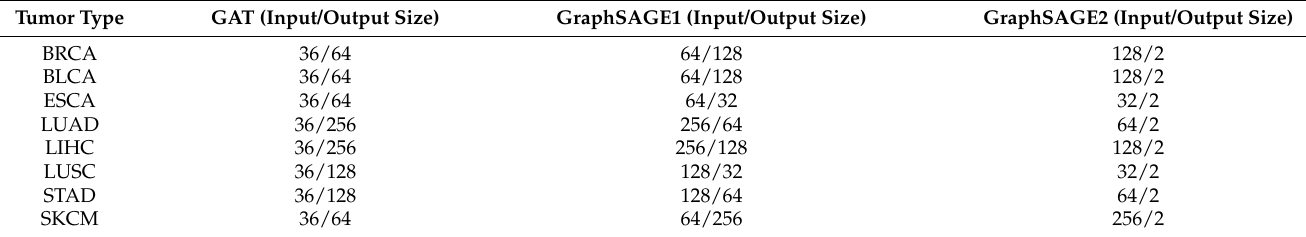
Table 3. Parameters of GGraphSAGE